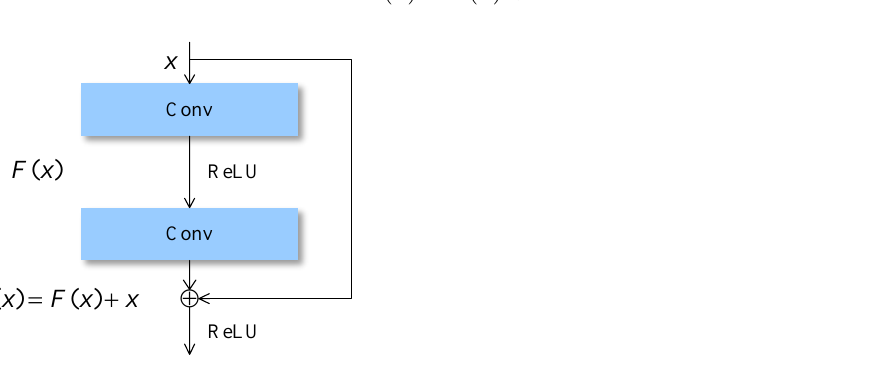
Figure 3. A residual block in ResNet34.